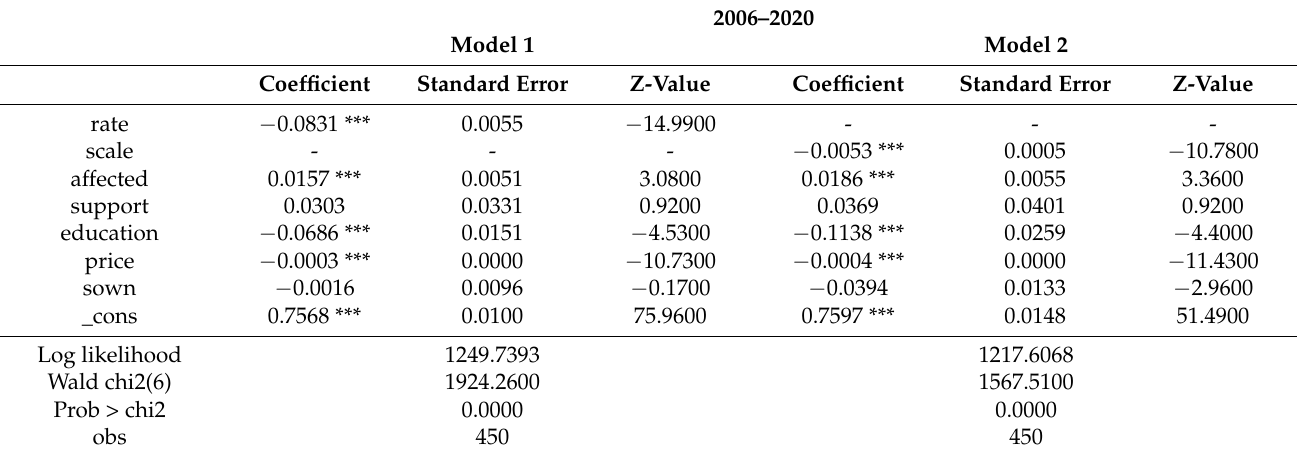
Table 3. Empirical analysis results of the impact of the rural land transfer market on agricultural technical